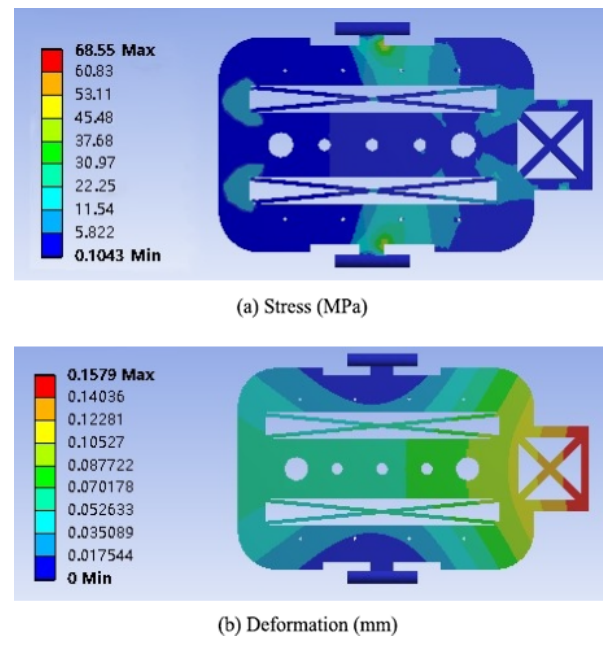
Figure 14. The cloud diagrams of the optimized stress and defor- mation of the frame.